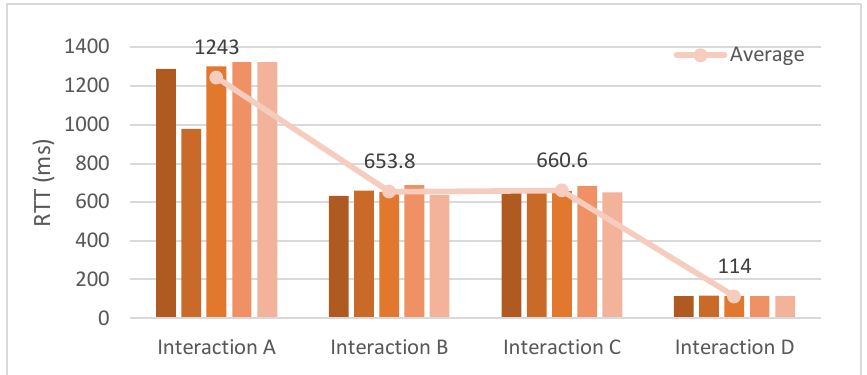
Figure 17. Comparison of RTTs for accessing services.